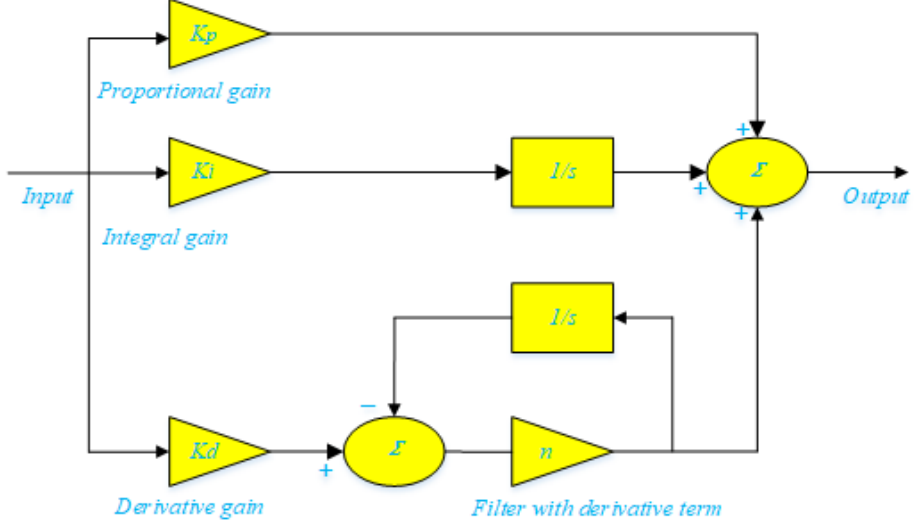
Figure 2. PID controller diagram containing a derivative filter component.